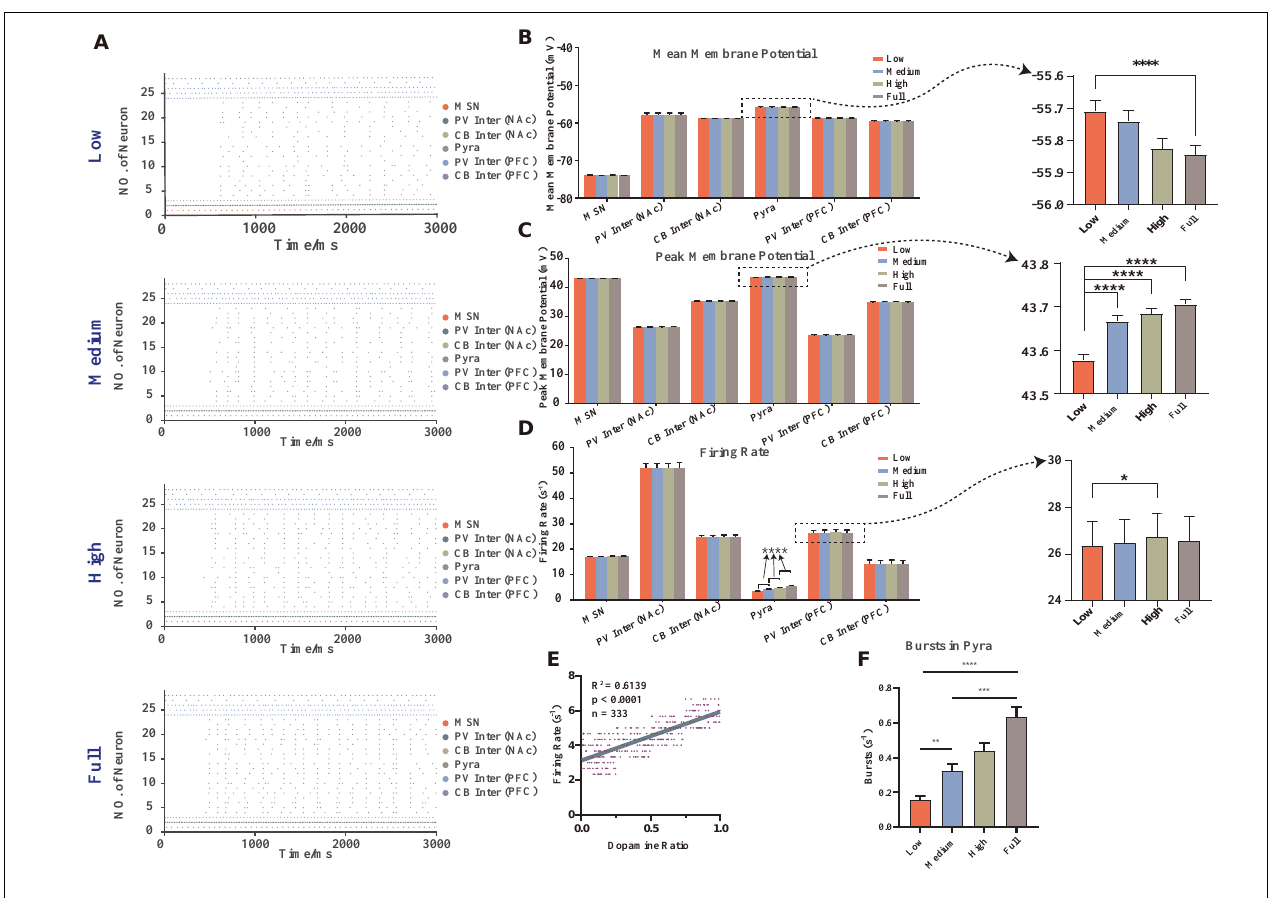
FIGURE 2 | The membrane potentials of different neurons under random dopamine concentration gradients. (A) Selected one results of the firing sequence of the action potentials under different dopamine concentrations: low (0–25%), medium (25–50%), high (50–75%), full (75–100%), the strength of connections and stimulus were same (vertical coordinate: neuron number, horizontal coordinate: time, each point showed that the neuron had one action potential at the corresponding moment, different colors were the different types of neurons). (B) Statistical results of the mean membrane potentials, which were significantly higher in pyramidal neurons at low concentration than at full concentration, n = 180, Brown-Forsythe and Welch one-way ANOVA. (C) Statistical results of the mean peak action potentials, when the dopamine concentration increased, the mean peak action potentials in pyramidal neurons significantly increased, n = 180, Brown-Forsythe and Welch one-way ANOVA. (D) Statistical results of action potential firing rates, when the dopamine concentration increased, the firing rate of pyramidal neurons significantly increased ( n = 180, Brown-Forsythe and Welch one-way ANOVA), and the firing rate of the high concentration was founded significantly higher than that of low concentration of PV interneuron in mPFC ( n = 27, repeated measured one-way ANOVA). (E) The regression analysis of the firing rates of pyramidal neurons in mPFC with different dopamine concentrations. (F) The statistical results of the burst firing of pyramidal neurons, which demonstrated that while the dopamine concentration increased, the frequency of burst firing rose, n = 180, Kruskal-Wallis test. All the statistically significant differences were visualized in the graph. * p < 0.05, ** p < 0.01, *** p < 0.001, **** p < 0.0001, means ±